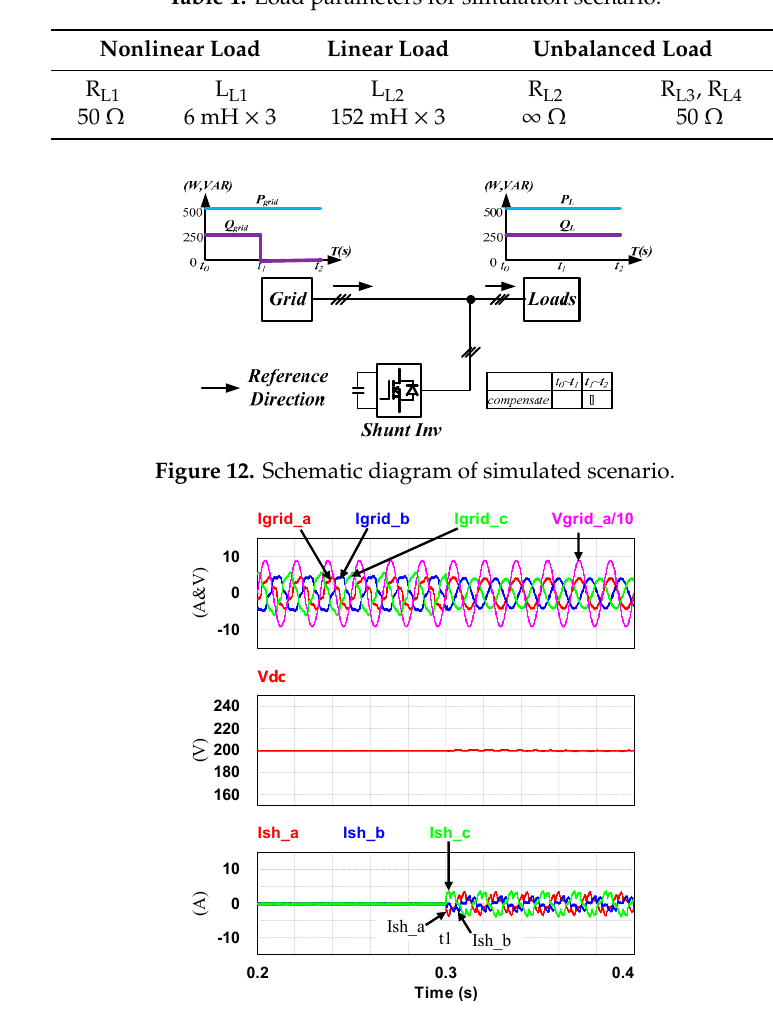
Figure 13. The grid-side phase-a voltage and three-phase currents/DC link voltage/shunt APF three- phase currents (t 0 –t 2 ).